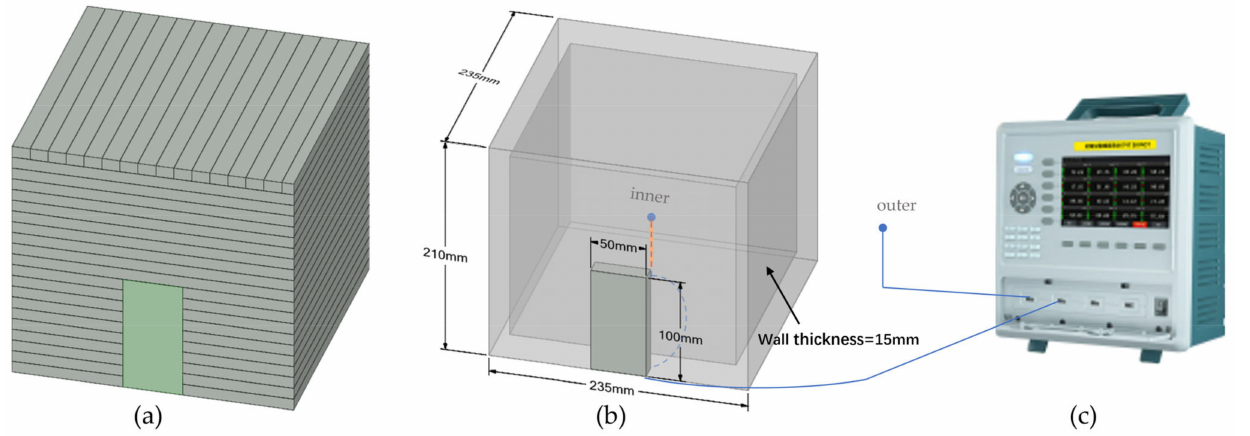
Figure 7. CAD of the room model for the thermoregulation test: ( a ) size of the room model, ( b ) fin- ished room model and the inner thermal sensor, and ( c ) the temperature logger TOPRIE-TP700 and the outer thermal